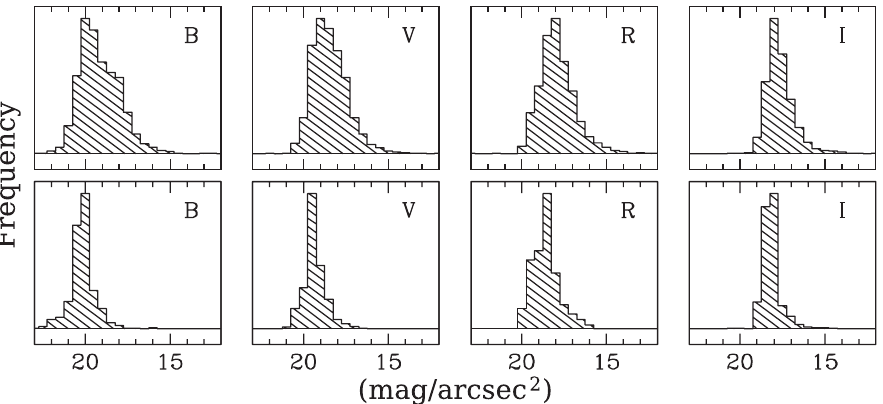
Fig. 7. The frequency distribution of the sky brightness (expressed as mag per arcsec 2 ) in ANS observations of symbiotic stars. The upper row is the cumulative distribution of all observations, irrespective of the Moon phase and height above the horizon, sky conditions and zenith distance. The lower row still averages over all sky conditions but it is restricted to zenith distances (cid:20) 20 ◦ and the Moon 10 ◦ below the local horizon.